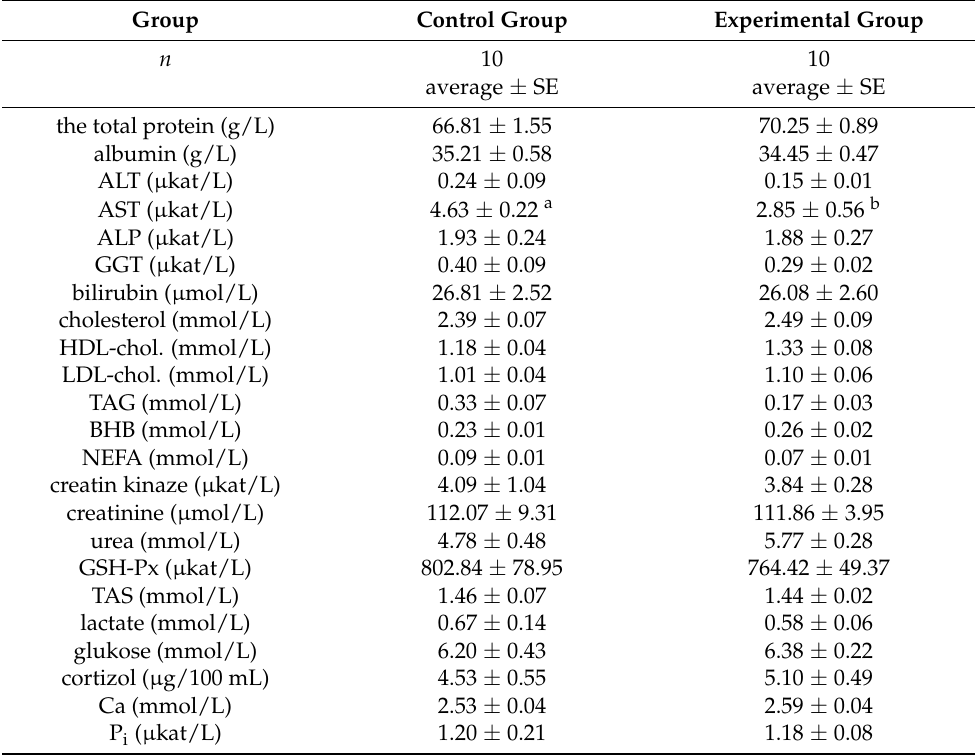
Table 4. Blood sample two: before the beginning of the experiment on day 56. Group Control Group Experimental Group